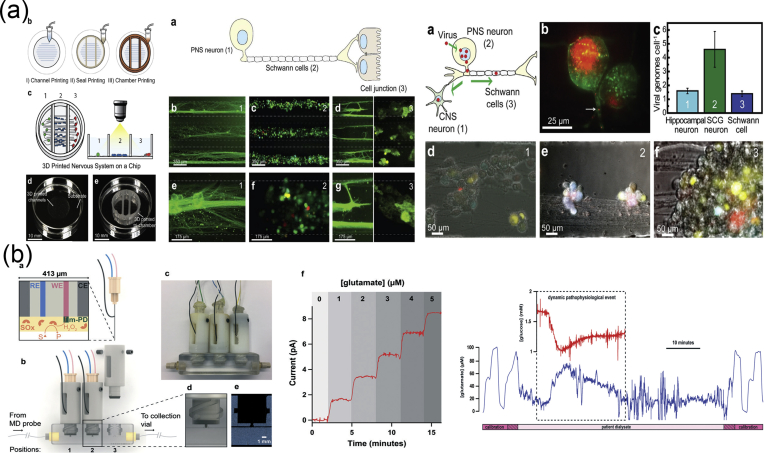
Three-dimensional printed lab-on-a-chip devices for neuroscience applications. (a) Microextrusion-based 3D printing of an in vitro platform for the study of viral infection in the nervous system [217]. (b) Use of SLA-based and inkjet-based 3D printers for the manufacturing of a microfluidic biosensing platform for online monitoring of the chemical changes in the human brain [219]. Images adapted with permission from (a) Johnson et al. [217] and (b) Samper et al. [219]. PNS, peripheral nervous system; 3D, three-dimensional; SLA, stereolithography.